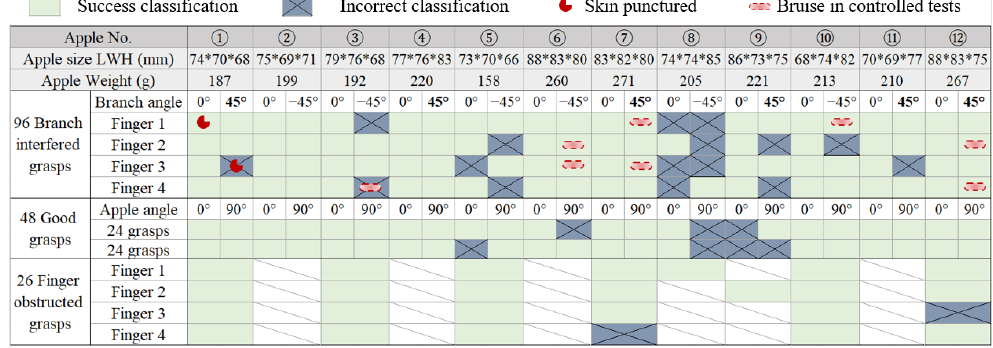
Figure 8. Grasping status experiment